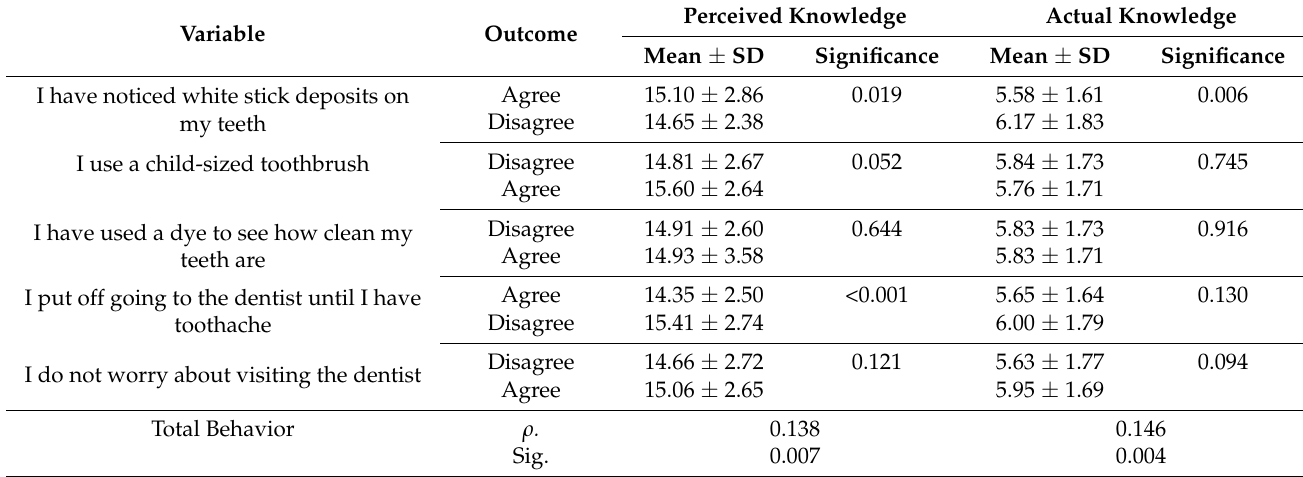
Table 8. Impact of elementary schoolteachers’ oral health knowledge on their behaviours.